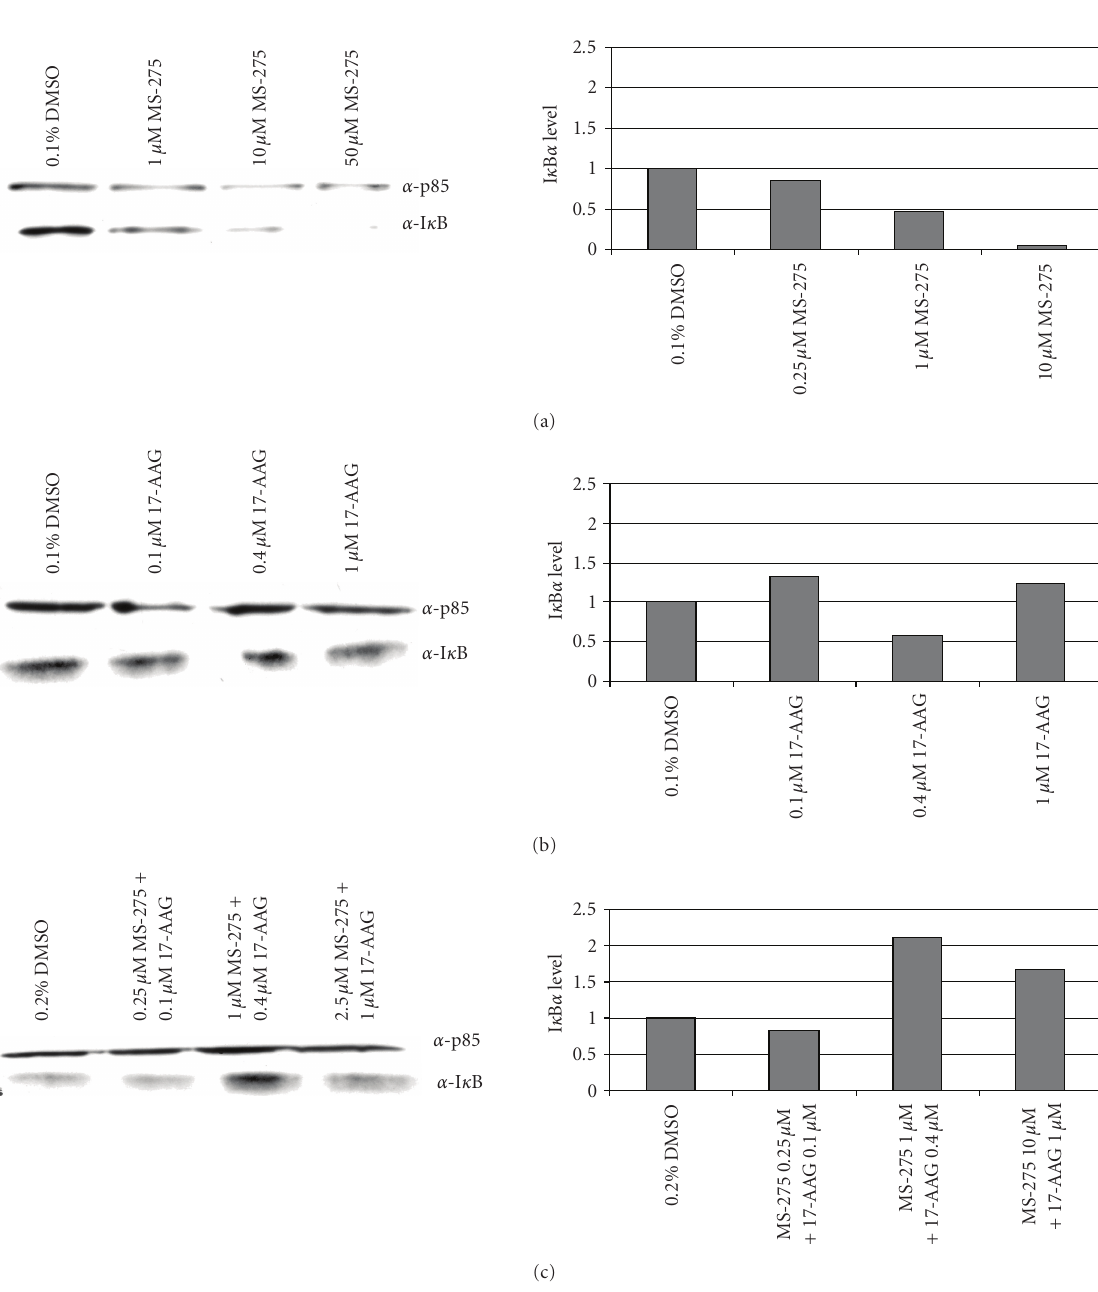
Figure 2: Dose Response of I κ B α . Immuunoblots and quantitation of I κ B α levels after treatment with (a) MS-275, (b) 17-AAG and (c) Combination. Following 24 hour treatment total lysates were prepared and quantified. 10 μ g of lysate was run on an SDS-page gel. By immunoblotting, I κ B α and p85 (as a loading control) were detected using α -I κ B α and α -p85 antibodies. Protein levels following treatment are compared to vehicle control which is set at